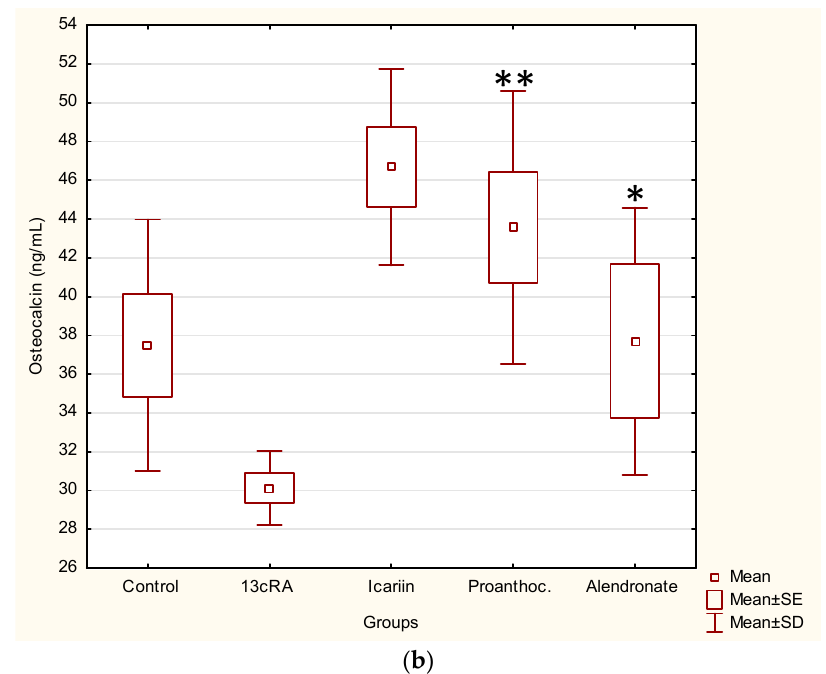
Figure 4. Effect of icariin, proanthocyanidins and alendronate on bone biochemical markers in rats with retinoic acid-induced bone loss. Bone biochemical markers ( a ) osteocalcin, a marker of bone formation and ( b ) β -CrossLaps ( β -CTx) marker of bone resorption. Rats were administered ig with retinoic acid suspension (80 mg kg − 1 ) once daily for 14 days. After inducing osteoporosis with 13cRA, rats were administered ig with icariin (100 mg kg − 1 ), proanthocyanidins (100 mg kg − 1 ) or alendronate (40 mg kg − 1 ) once daily for next 14 days. Serum osteocalcin and β -CrossLaps ( β -CTx) markers were measured by the e lectro c hemi l uminescence i mmuno a ssay “ECLIA”. Number of rats per group: 7. ( a ) Statistically significant difference exists between: 13cRA vs. control (** p < 0.01). ( b ) Statistically significant difference exists between: 13cRA vs. icariin (** p < 0.01); 13cRA vs. proanthocyanidins (* p < 0.05).